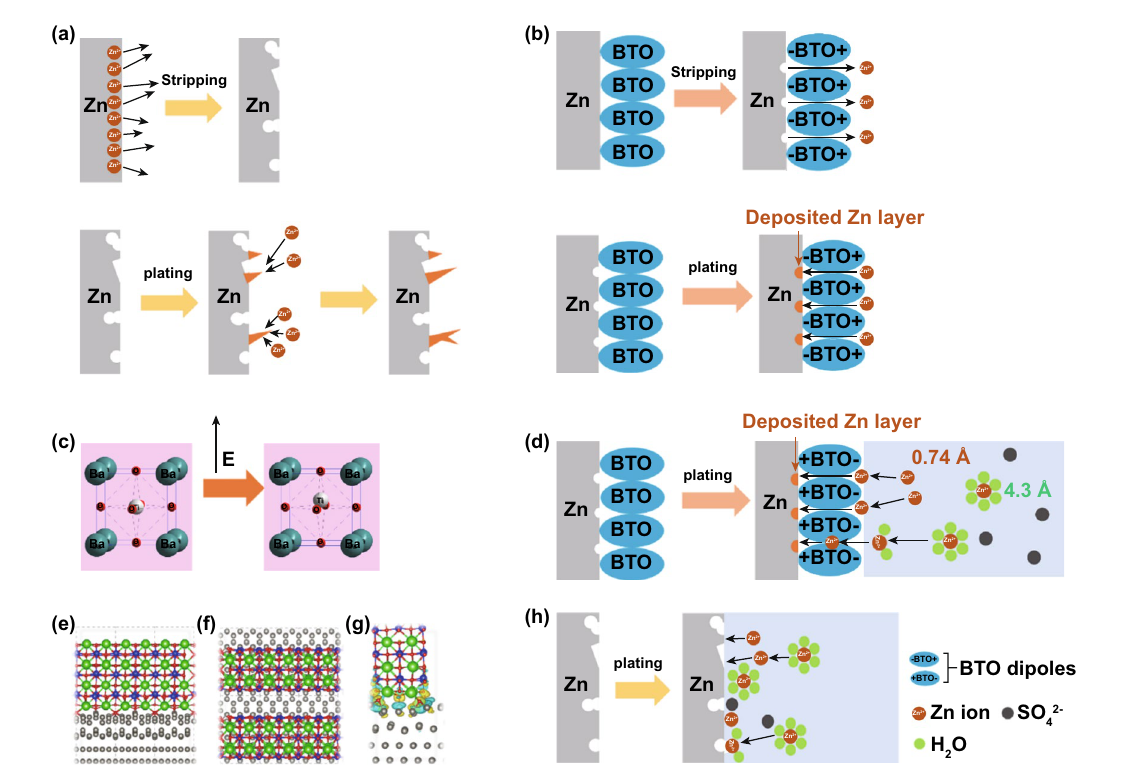
Fig. 1 Schematic of zinc ion transport during Zn stripping/plating for: a bare Zn, b BTO@Zn foil. c Schematic diagram of the Ti ion migration in the [TiO 6 ] octahedral interstitial sites under the external electric field. d Schematic of the mechanism of zinc ion transport at the BTO@Zn/ electrolyte interface during Zn plating process. Schematic illustration of the BTO@Zn surface used in the simulation: e side view, f top view. The bottom two Zn layers are fixed during the geometrical optimization. Ba, Ti, O, Zn atoms are represented by green, blue, red, gray spheres, respectively. g Differential charge density ( ρ diff = ρ BTO@Zn – ρ BTO – ρ Zn ) of the BTO@Zn surface. Yellow and blue surfaces indicate the electron gain and loss, respectively. h Schematic diagram of zinc ion transport at the Zn anode/electrolyte interface during Zn plating